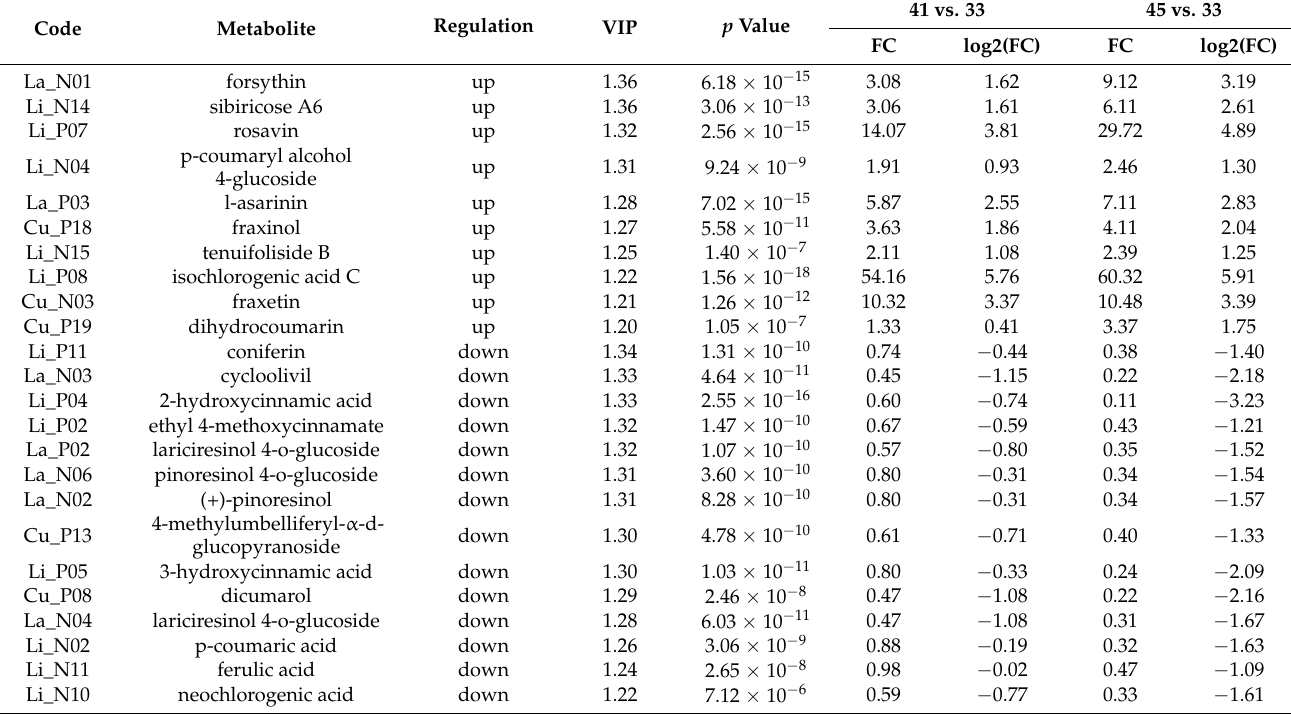
Table 3. Differential metabolites screened at the three developmental stages of apricot